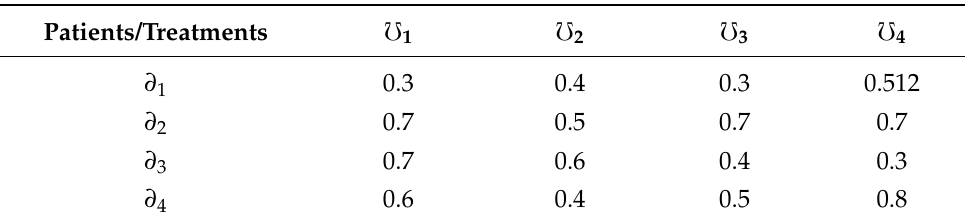
Figure 6. Graph of progress of patient ∂ 4 . Table 13. W 1 tabular representation: union of χ F (cid:48) and z (cid:48) F (cid:48) to investigate the affiliation for both C envisaged treatments and patients.